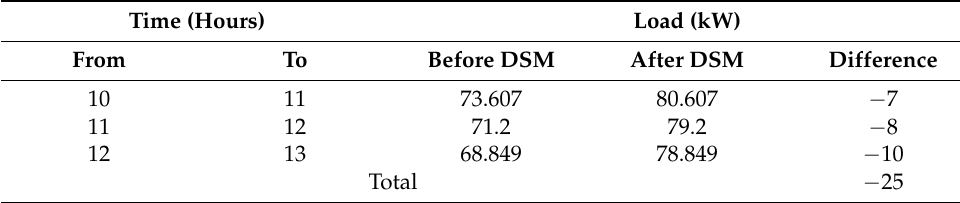
Figure 5. Load shifting in daily load profile. Table 6. Peak clipped 25 kW load shifted from afternoon to